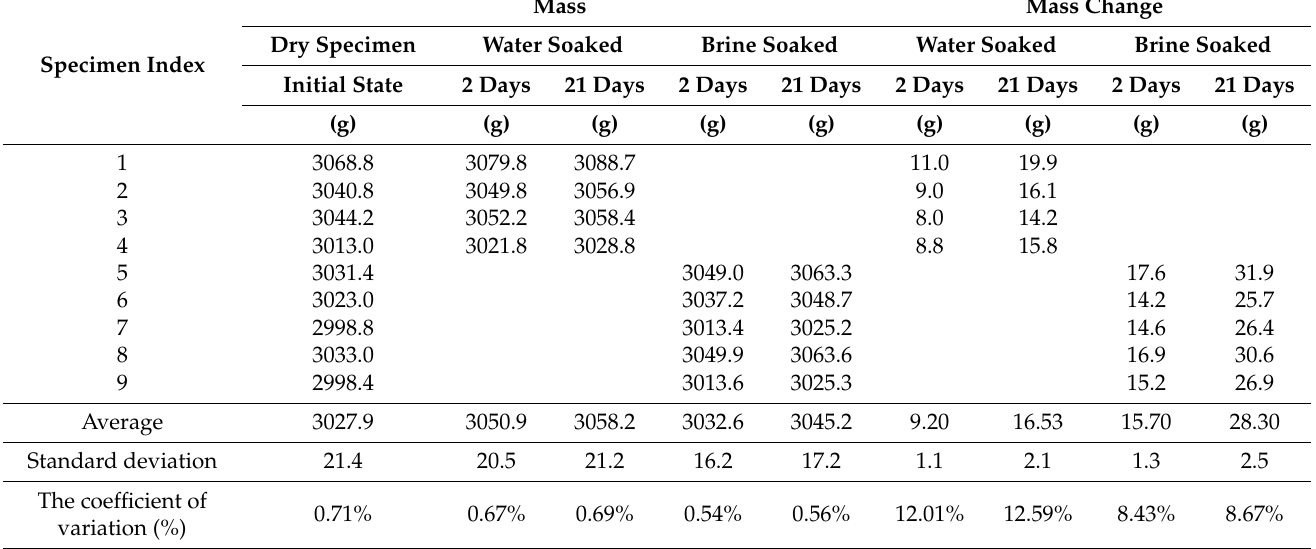
Table 7. Mass variability of AC 22 WMS(HIMA) via soaking in water and